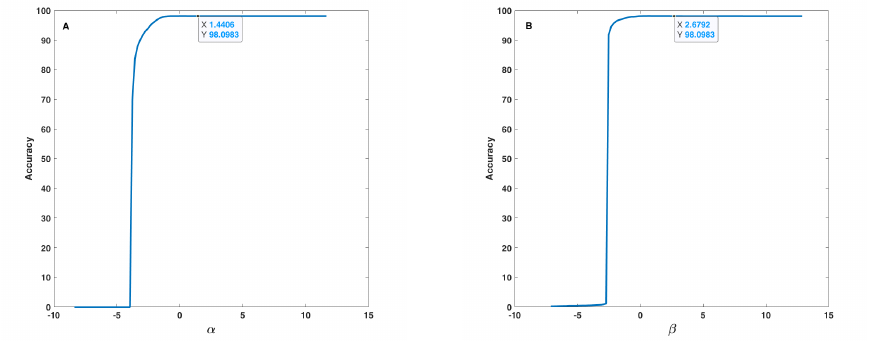
Figure 10. Accuracy in terms of α ( A ) and β ( B ) parameters used in the fusion step (Equation (14)).